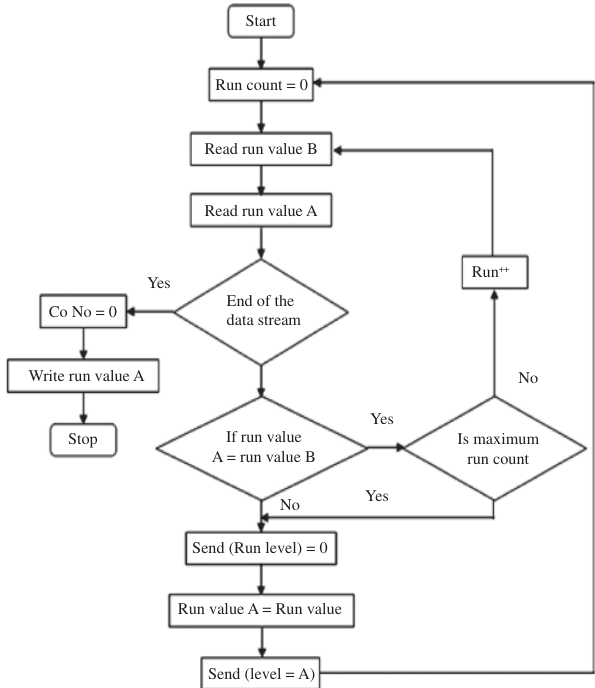
Figure 6: Flow Chart for RLC